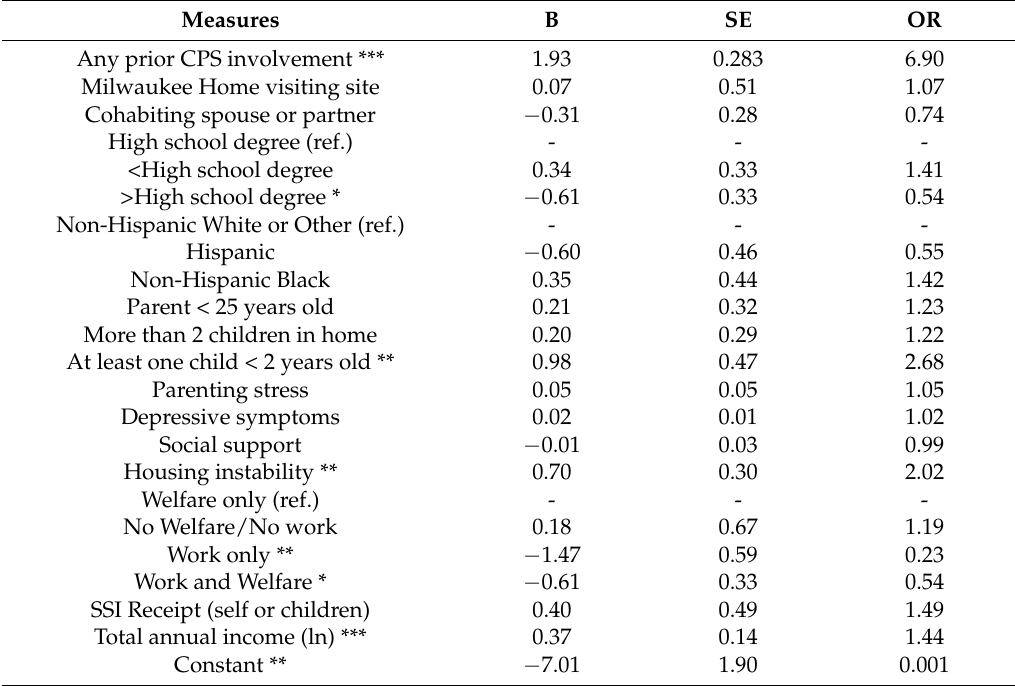
Table 2. Logistic regression predicting CPS involvement ( n =